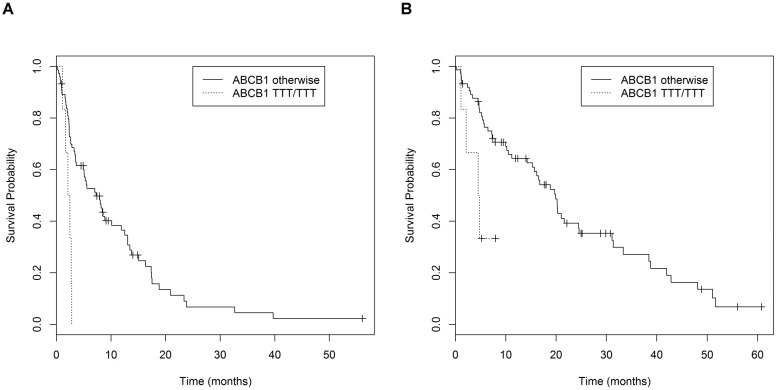
Survival curves.(A) Patients grouped according to the ABCB1 3435C/T, 1236C/T, 2677G/T haplotype; median PFS was 2.4 months for homozygous carriers of the TTT haplotype and 8.4 months for other cases (P = 0.001). (B) Patients grouped according to the ABCB1 3435C/T, 1236C/T, 2677G/TA haplotype; median OS was 4.6 months for homozygous carriers of the TTT haplotype and 19.6 months for other cases (P = 0.005).